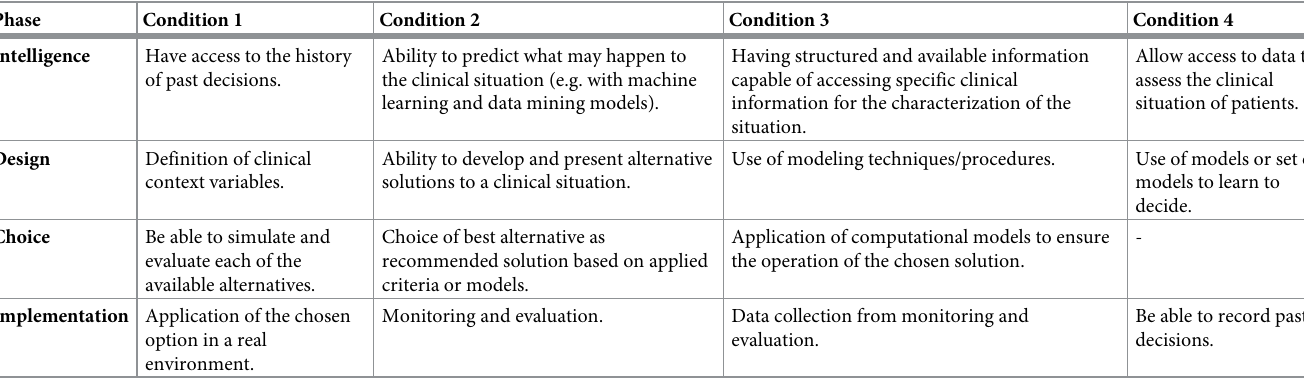
Table 2. Choice of criterias for the classification of Simon’s